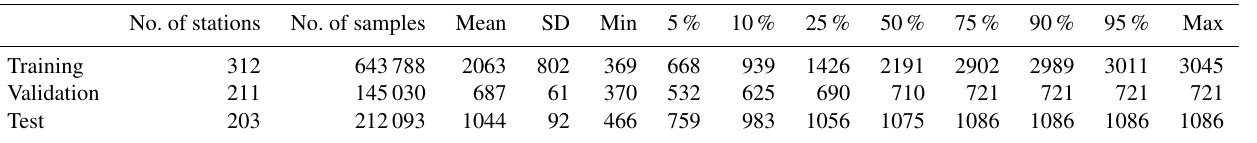
Table 4. Number of stations, total number of samples (pairs of X and y ), and various statistics of number of samples per station in the training, validation, and test datasets. The number of stations per set varies as not all stations have data through the full period (see Table A1 for